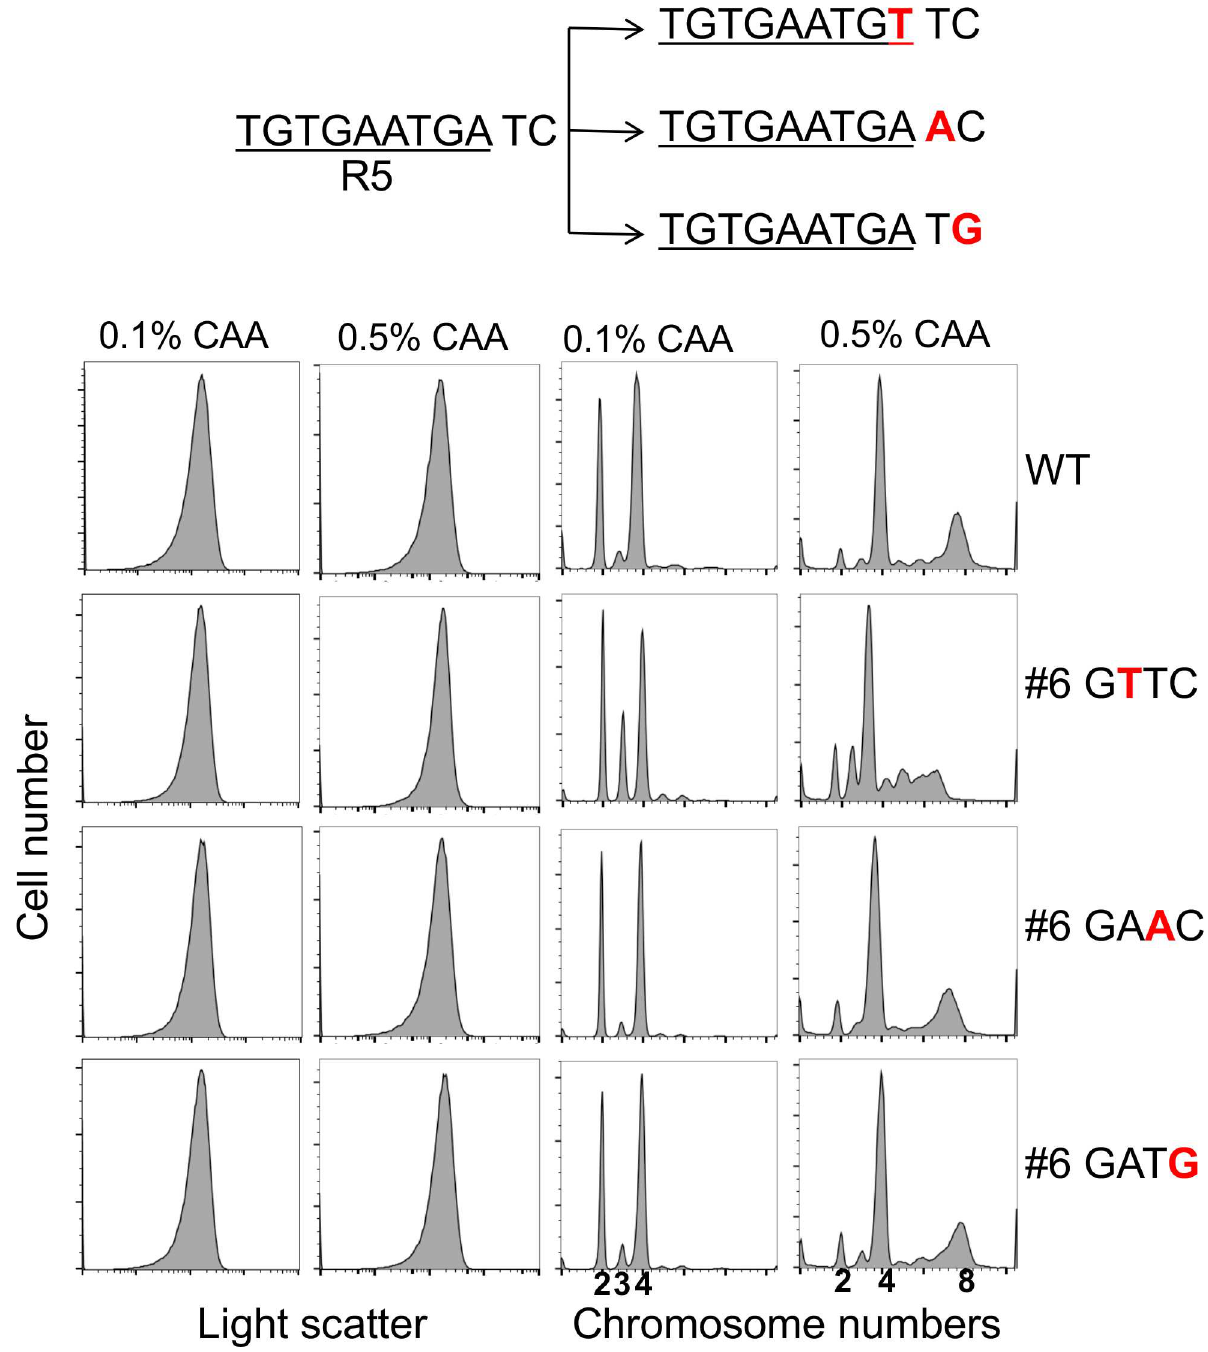
Fig 5. Importance of integrity of the DnaA binding site R5 and not its methylation in initiation synchrony. The overlappingGATC site of R5 was mutated at three positions(shown in red), two of which resideoutside of the canonical9-mer DnaA bindingsite (underlined). Cell sizes and chromosome contents of the above GATC mutants were determined as in Fig 4A, using two different concentrations of casaminoacids